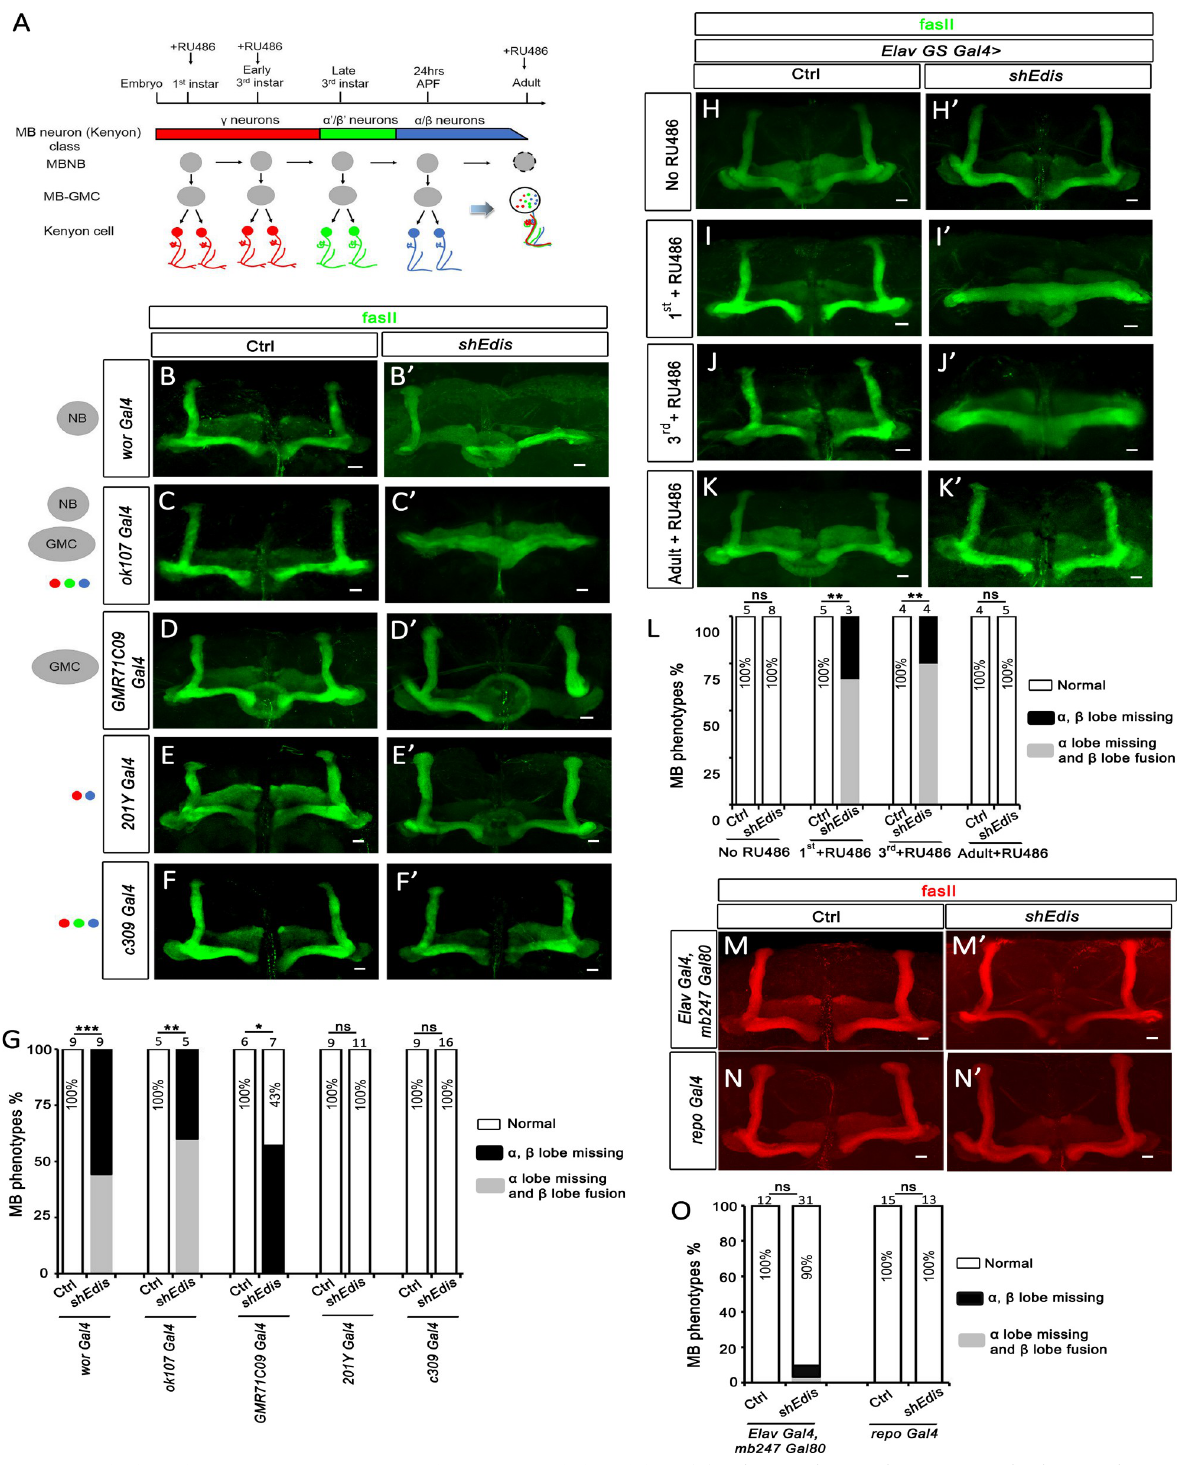
Fig 2. Loss of Edis in the MB neuron precursors results in MB morphology defects. ( A ) A diagram showing the MB neuron developmental process during the Drosophila lifecycle (modified from [43,48]). MB neuroblasts (MBNB) keep dividing to produce the MB ganglion mother cells (GMC) and further produce mature MB neurons (Kenyon cells) until the adult stage, in which MBNB undergoes apoptosis [51]. ( B - F’ ) The MB morphology phenotypes in flies of indicated genotypes. MB morphology defects were observed when UAS-shEdis was driven by wor - Gal4 ( B , B’ ), ok107 - Gal4 ( C , C’ ), and GMR71C09 - Gal4 ( D , D’ ). These drivers can induce transgene expression in the MB neuron precursors (MBNB and/or